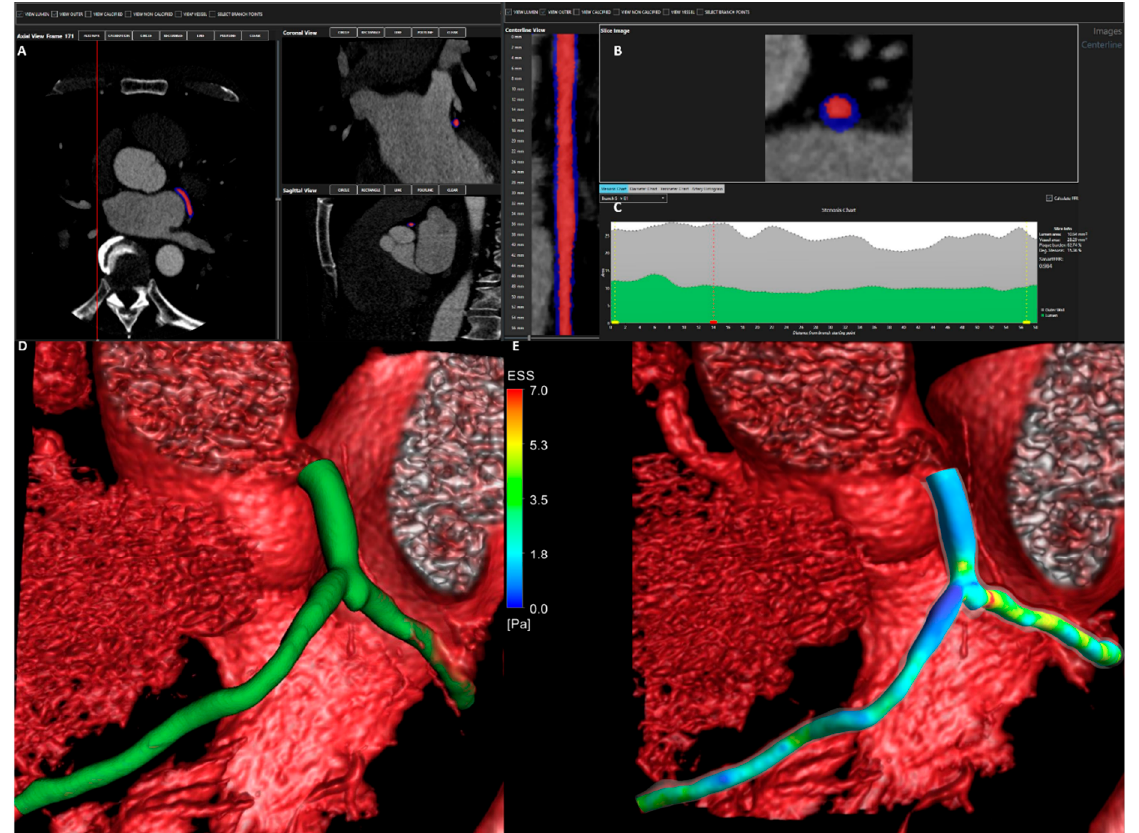
Figure 2. Example of a patient case as analyzed using the developed software. Panels A and B present the segmentation results, panel C shows the calculated SmartFFR for one branch, as well as metrics of lumen and wall area and plaque burden among the vessel’s length. Panel D presents the reconstructed geometry back-projected on the coronary computed tomography angiography (CCTA) volume rendering and panel E shows the ESS distribution on the analyzed vessel.